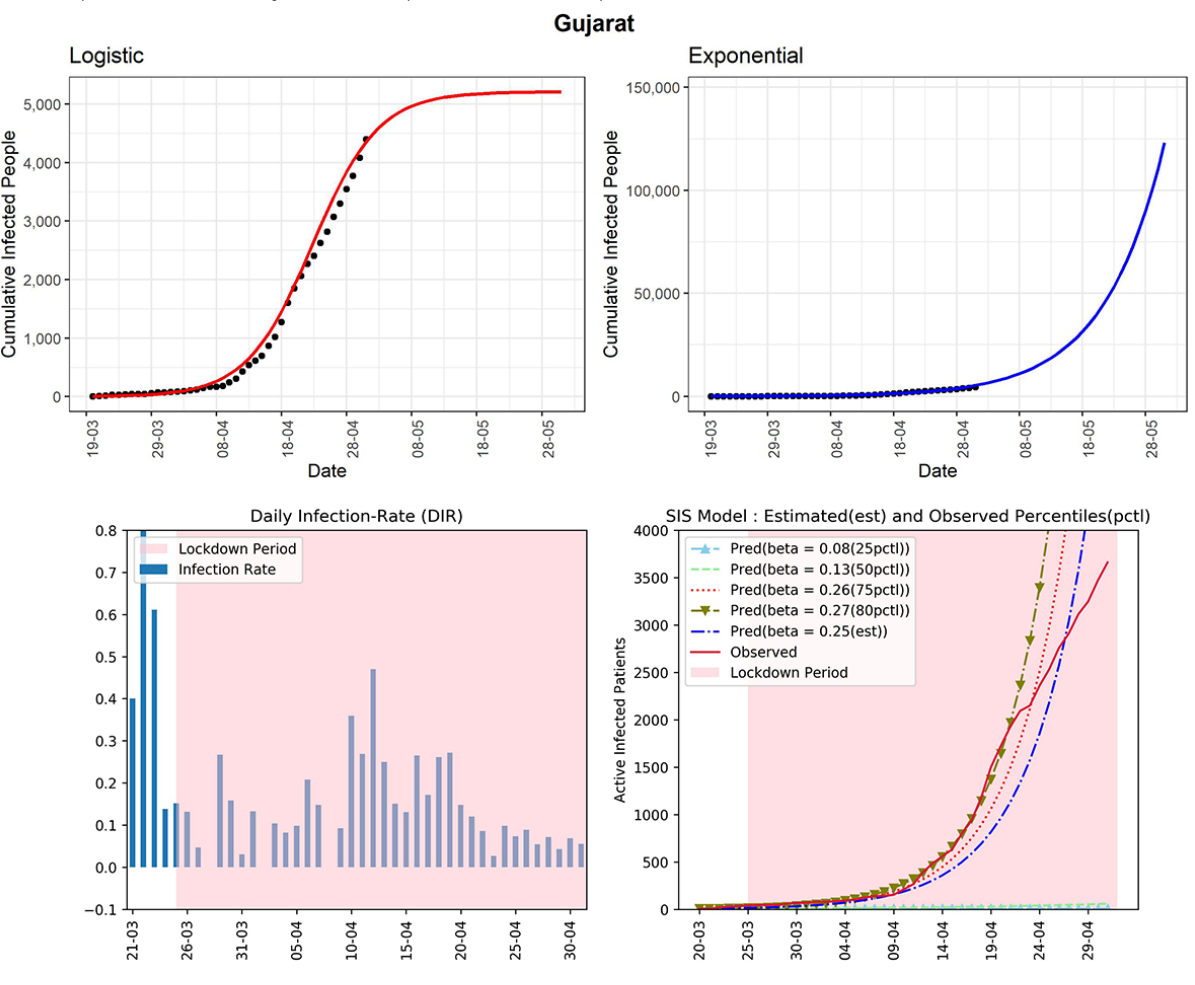
Figure 9. Graphs for the state of Gujarat. SIS: susceptible-infectious-susceptible.